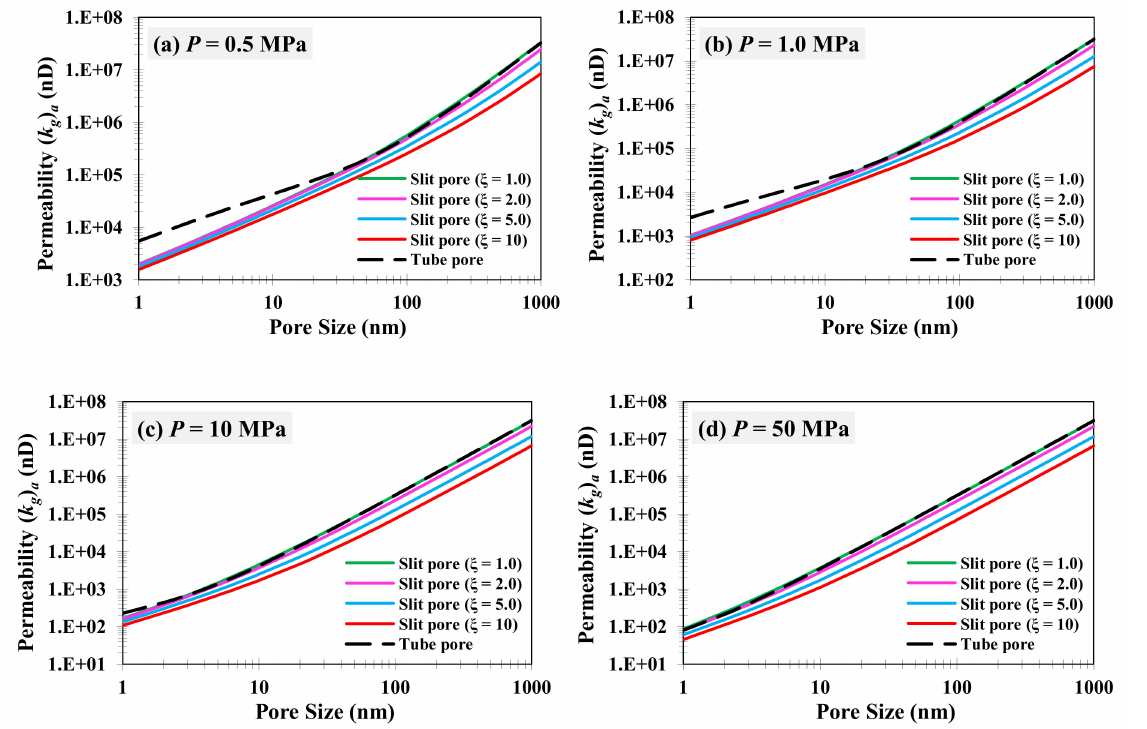
Figure 7. Comparison of permeability between slit and circular pores with the same area. Equation (31) shows that the slit width H of the rectangular pore is constantly smaller than the diameter D of the circular pore when the cross-sectional area is the same, whereas, the larger the aspect ratio ξ of the rectangular pore, the smaller the corresponding pore scale H . Under the same cross-sectional area condition, the pore characteristic scale of the circular pore is the largest and has the highest fluid transfer capacity, whereas the pore characteristic scale of the rectangular pore with ξ = 10 is the smallest and has the lowest fluid transfer capacity. It is worth noting that under low-pressure and microporous conditions, the Knudsen diffusion within the circular pore is significant and the apparent permeability is much larger than that of the rectangular pore case. Indeed, under these high-pressure and macroporous conditions, the gas flow within the pore is governed by viscous flow (slip flow), and the transport capacity of the circular pore is close to that of the rectangular pore. For the square pore at ξ = 1, its pore characteristic scale is close to the diameter of the circular pore; therefore, in the viscous flow (slip flow) stage, the gas transport capacity in both is basically the